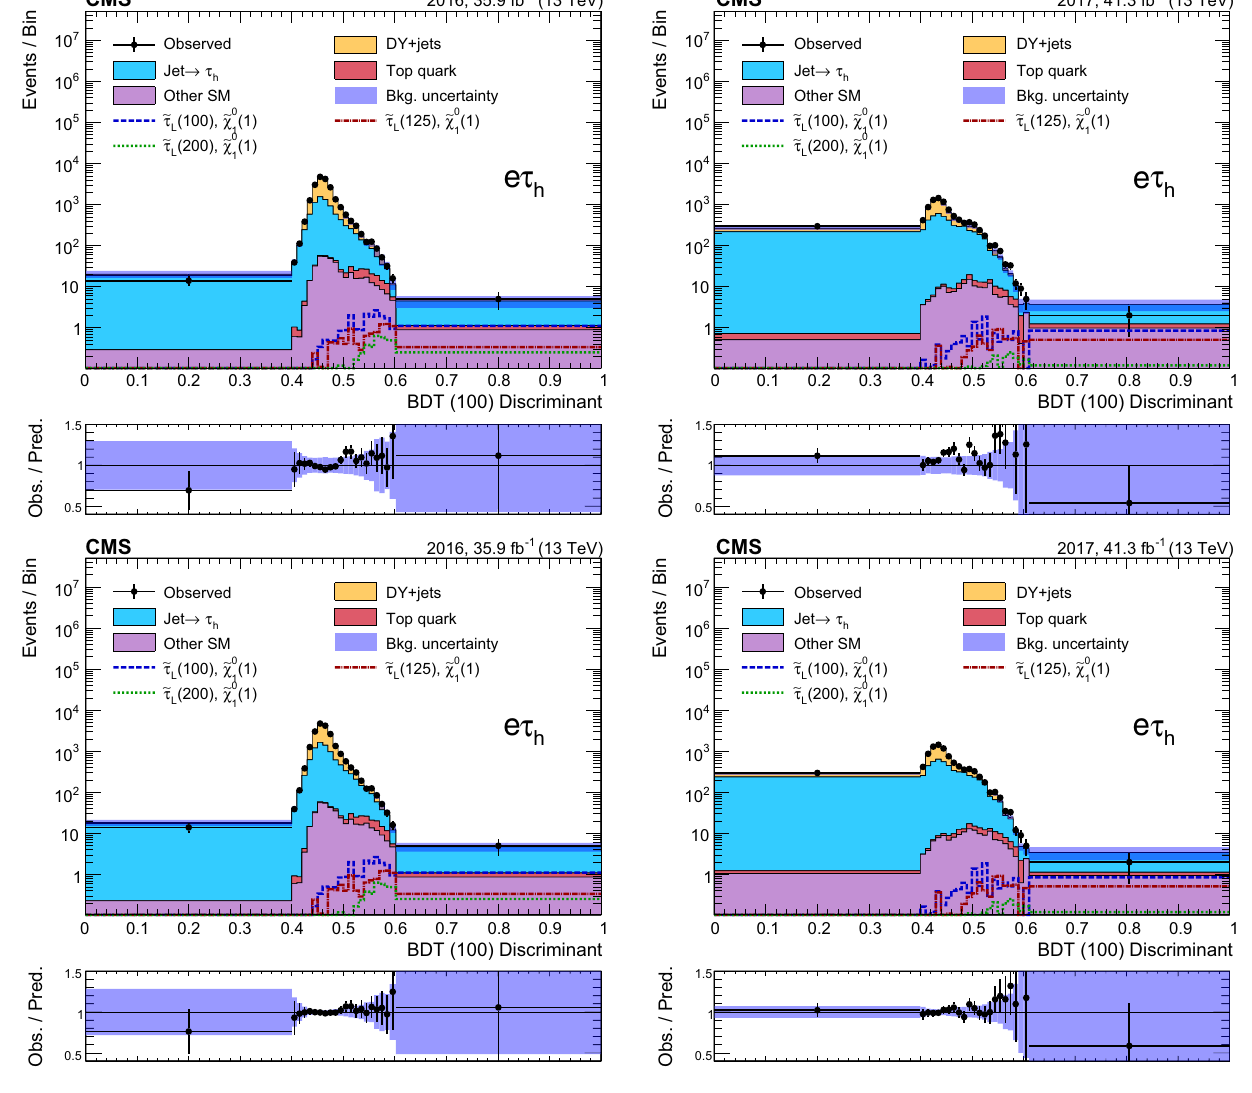
a maximum-likelihood fit to the data. Predicted signal yields are also shown for benchmark models of (cid:2) τ L pair production with m ( (cid:2) τ L ) = 100, final state for h ) = 1GeV 125, and 200GeV and m ( (cid:2) χ 0 1